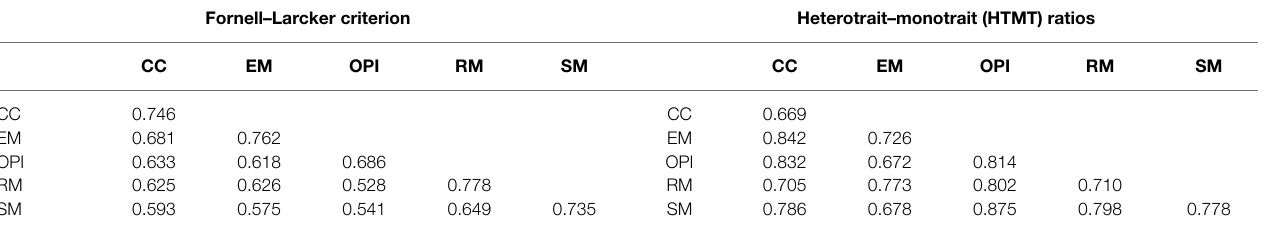
TABLE 4 | Discriminant validity.